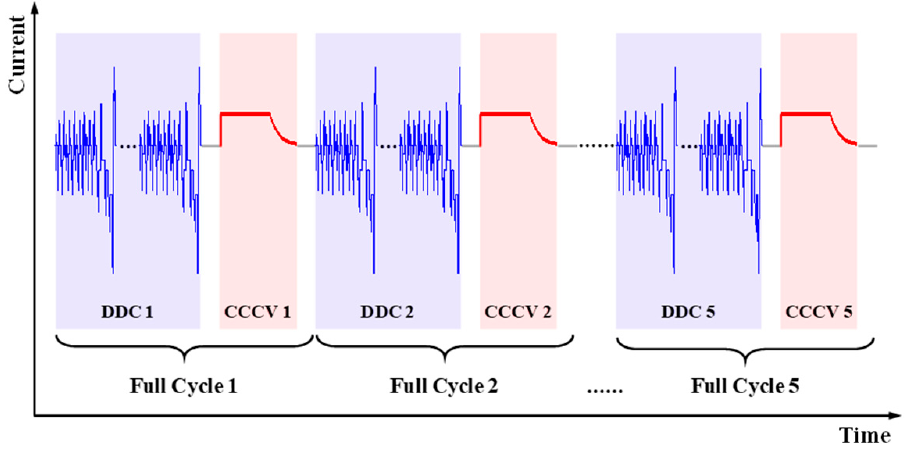
Figure 4. The current profiles of the designed experiment. Table 1. Cells used in the experiments.